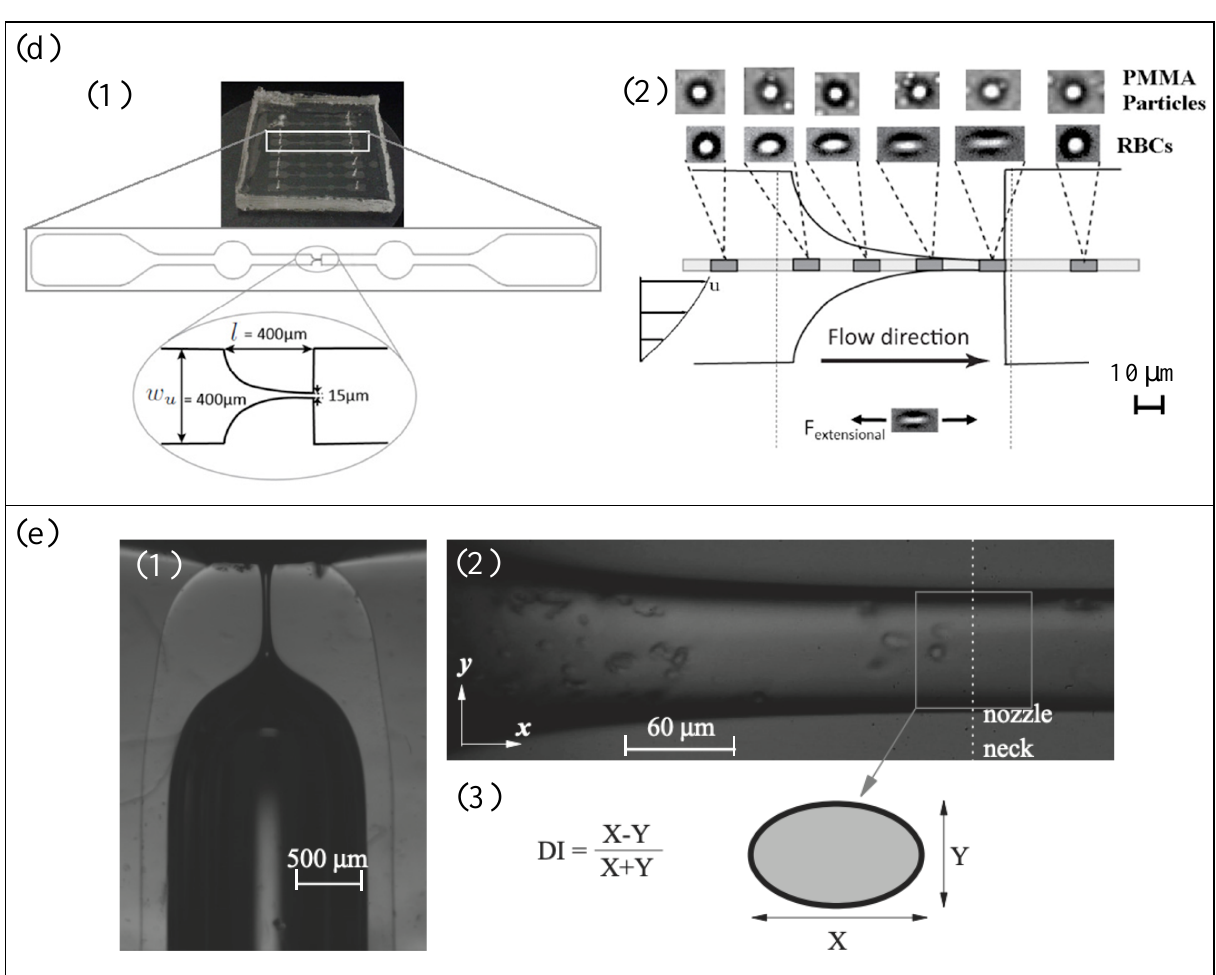
Figure 3. Deformation assessment of microparticles (RBC templates) from the literature: ( a ) PLGA RBC template flowing through a glass capillary (5 µ m inner diameter) (A), and outside the capillary (B) [34]; ( b ) illustration of the silicone microfluidic device packed with constricted pores (1), and image sequence showing how a single HEA hydrogel particle passed through a constricted pore (31 ms of time lapse between the frames) (2) [38]; ( c ) SEM image of the PDMS microfluidic device with the possible flow paths (1), and time-lapse fluorescence microscopy images of PEG hydrogel particles passing through the constrictions [42,43]; ( d ) picture and illustration of the PDMS microfluidic device with a hyperbolic microchannel (1), and an example of deformation of PMMA particles and RBCs [54]; ( e ) the whole geometry of the glass axisymmetric micronozzle used (1), visualization of microparticles flowing through the glass micronozzle (the dotted line points out the nozzle neck) (2), and deformation index (DI) definition (3) [50]. Reproduced from Refs. [34,38,42,43,50,54] with permission from National Academy of Sciences, American Chemical Society, WILEY-VCH Verlag GmbH & Co. KGaA, MDPI, and Elsevier Science